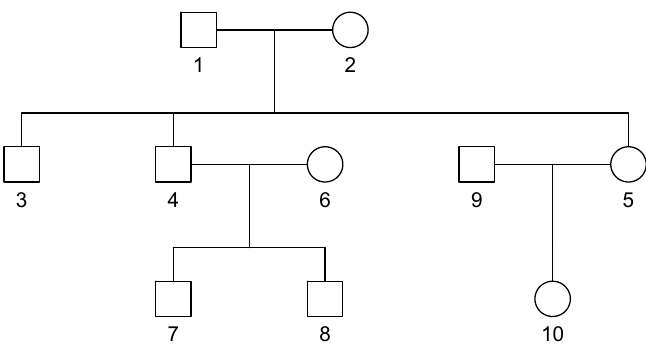
Figure 1. Pedigree for simulated data. Circle = Female, Square =